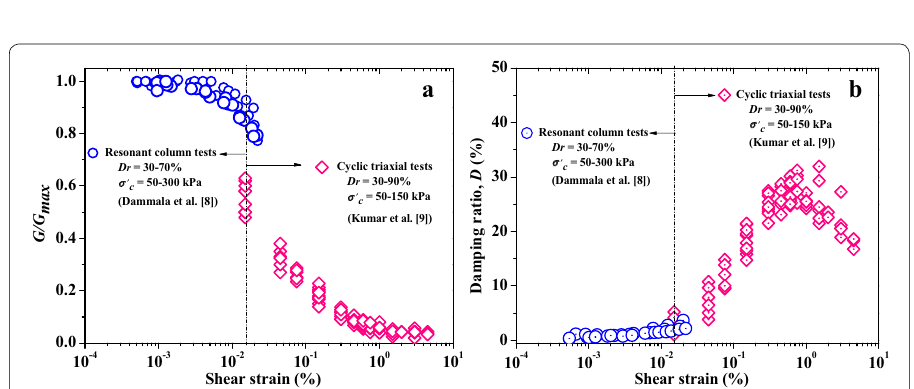
Fig. 13 Strain-dependent dynamic properties of cohesionless BS soil obtained from Resonant Column and Cyclic Triaxial tests a Modulus reduction curve, b Damping ratio curve (Dammala et al. [8], Kumar et al.